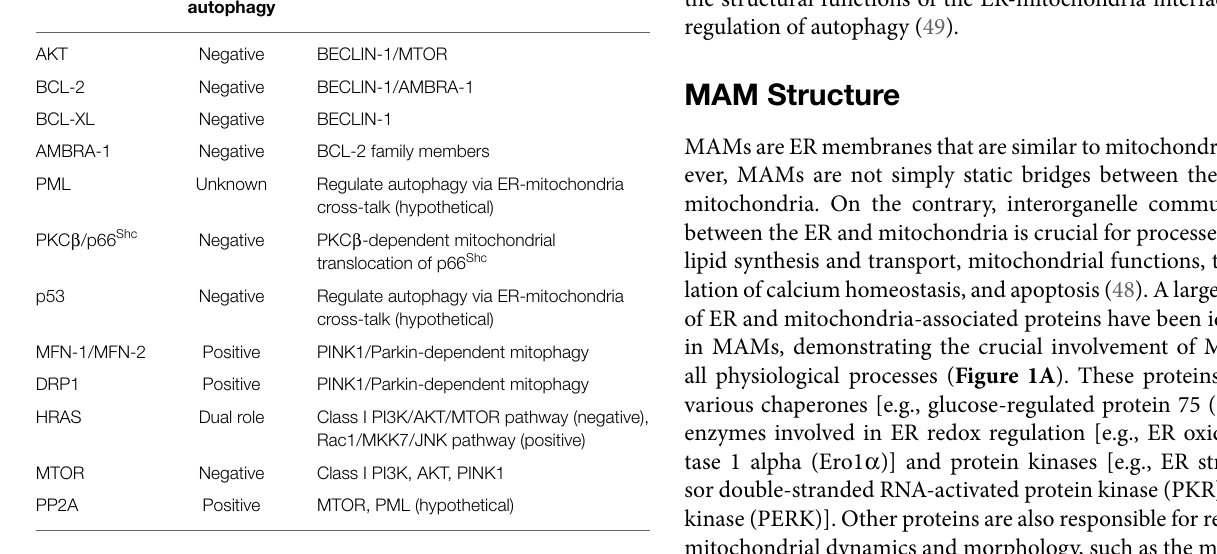
TABLE 2 | MAM cofactors regulating autophagic machinery . Protein